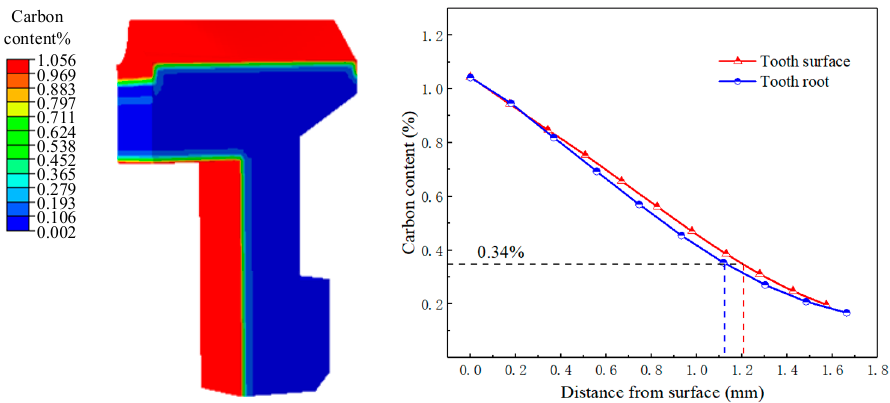
top: point D). The temperature of each point changed drastically within 200 s, and the temperature difference between inside and outside was essentially eliminated at around 400 s. The gear surface points A, C, and D were in direct contact with the quenching oil, and the temperature dropped rapidly. The temperature change rate of point D on the tooth top was the fastest, and the temperature change rate of point C at the root was the slowest. The temperature drop rate of point B was lower than that of point A due to the internal heat transfer of the gear. The temperature change curves of point B and point C were basically the same. The results showed that the temperature change was affected by the shape of the part, where the temperature at the top of the tooth changed most dramat- ically. Figure 9. Temperature variation during gear quenching. Figure 9. Temperature variation during gear